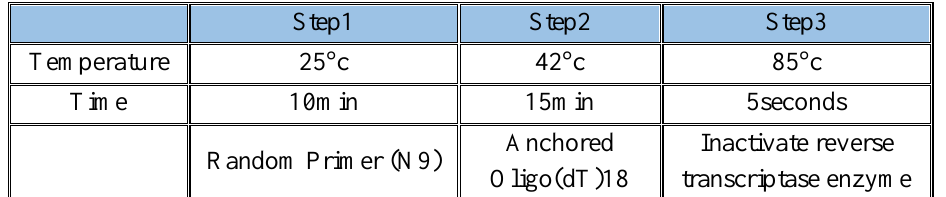
Table 3: Thermal cycler